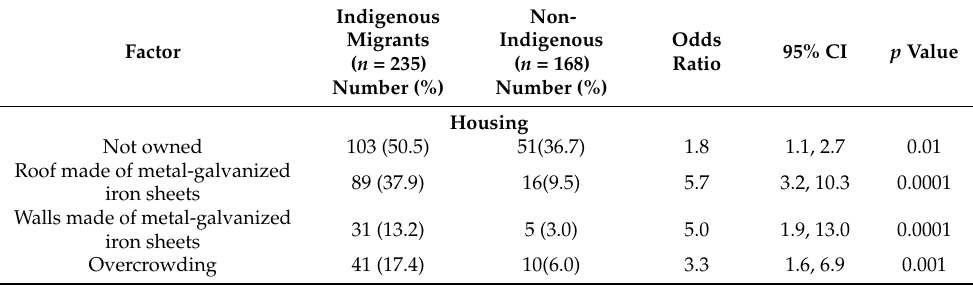
Table 2. Intermediary determinants of health according to indigenous migrant and non-indigenous cate-